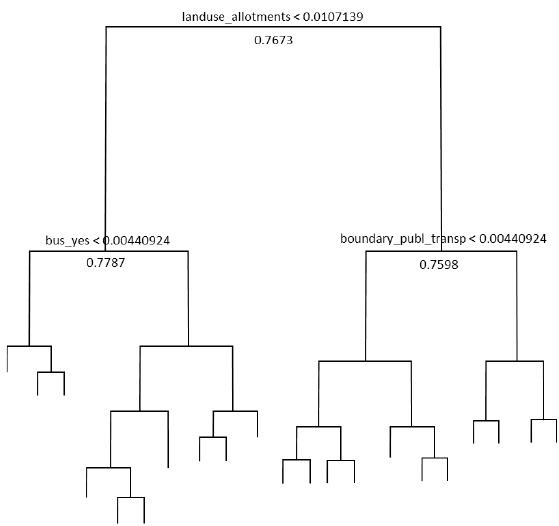
Figure 2. Regression tree age structure (labels of lower branches removed for reasons of readability) The number of levels, nodes and branches indicates over-fitting by the regression tree.